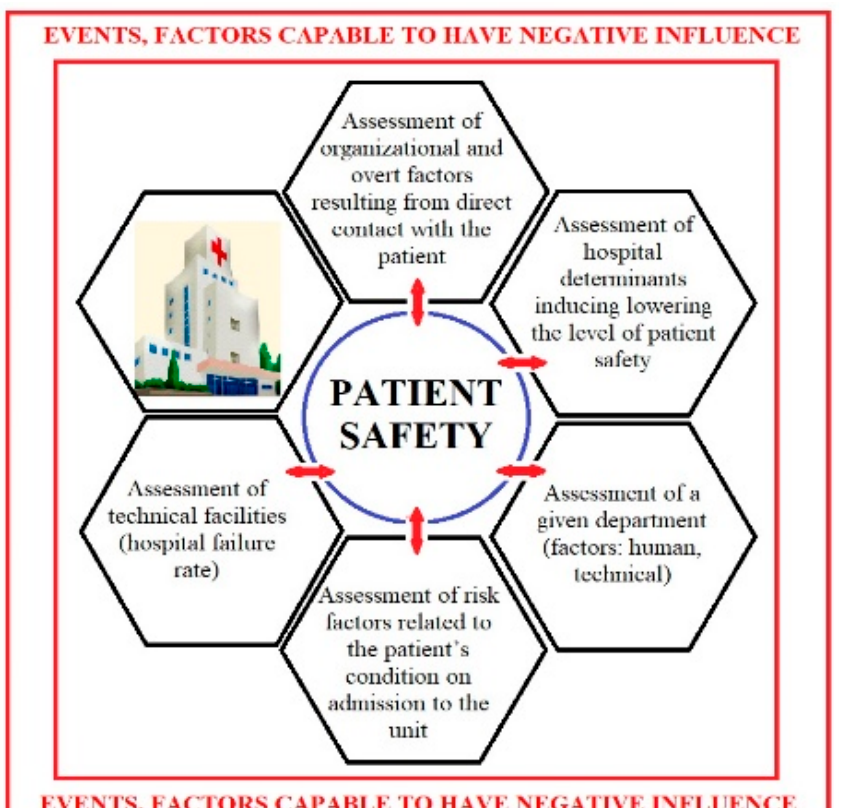
Figure 2. A competency model for predicting the risk of hazards and exposure to the risk of nosocomial infections.